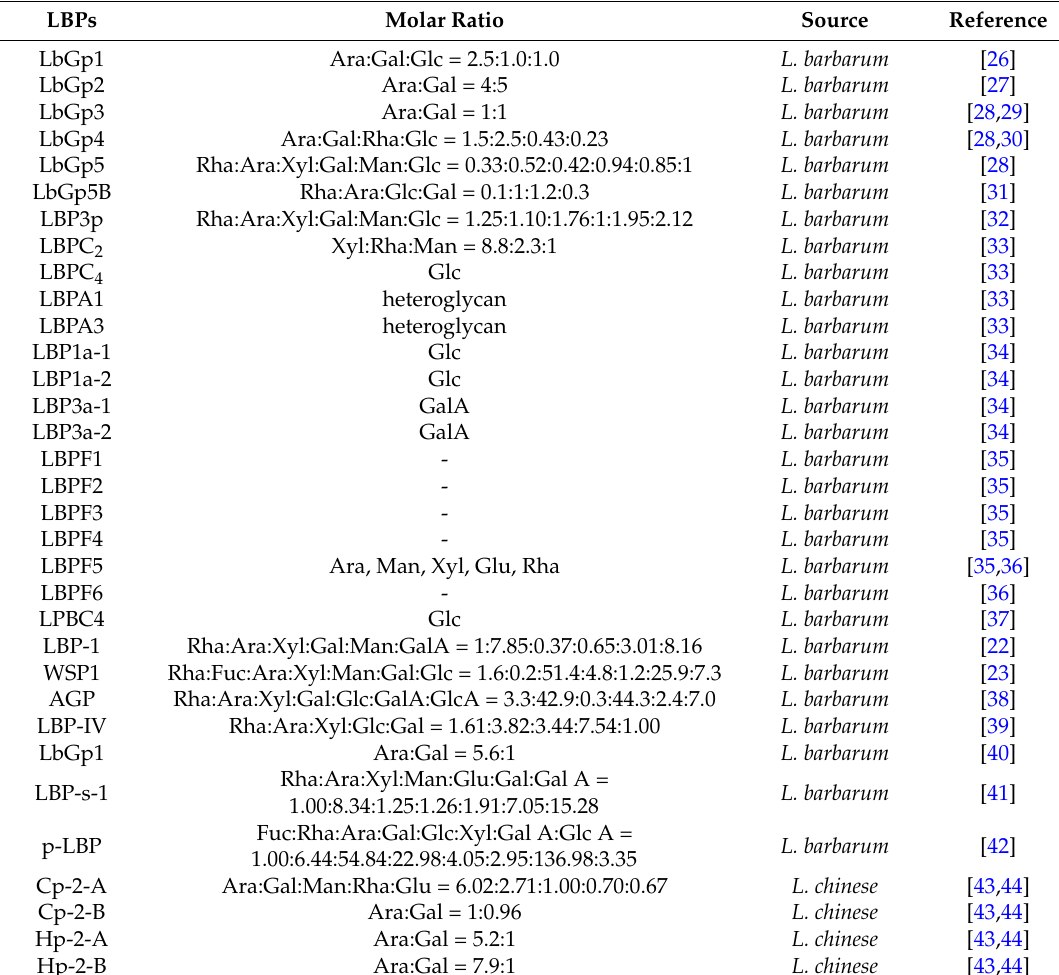
Table 1. The molar ratios and source of